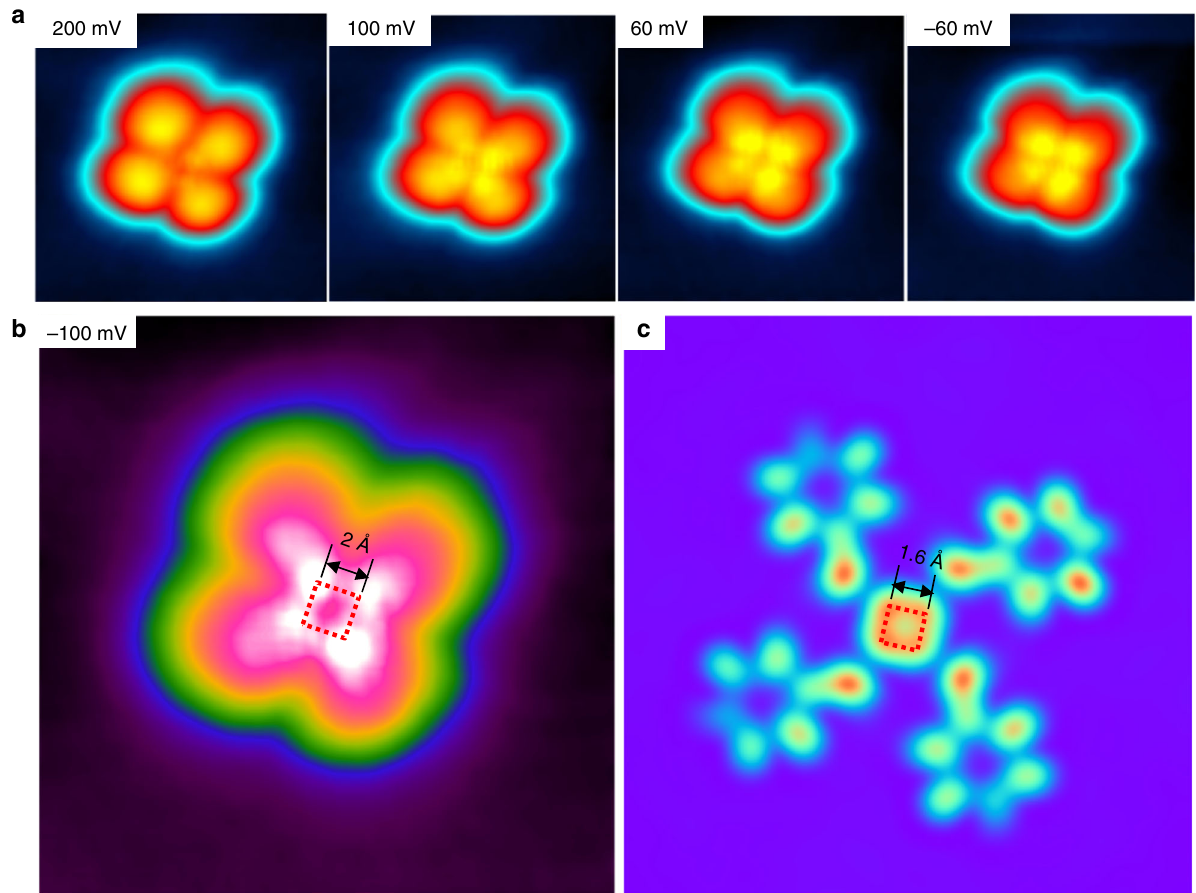
Fig. 4 STM image at lower bias voltages. a The STM topographic images of the tetramer products measured at 200 mV, 100 mV, 60 mV, and − 60 meV, respectively. b The STM topographic images of the tetramer product measured at − 100 mV. The square shows the size of the central four protrusions. c The simulated STM image of a tetramer product. All the STM topographic images were obtained with I t = 100